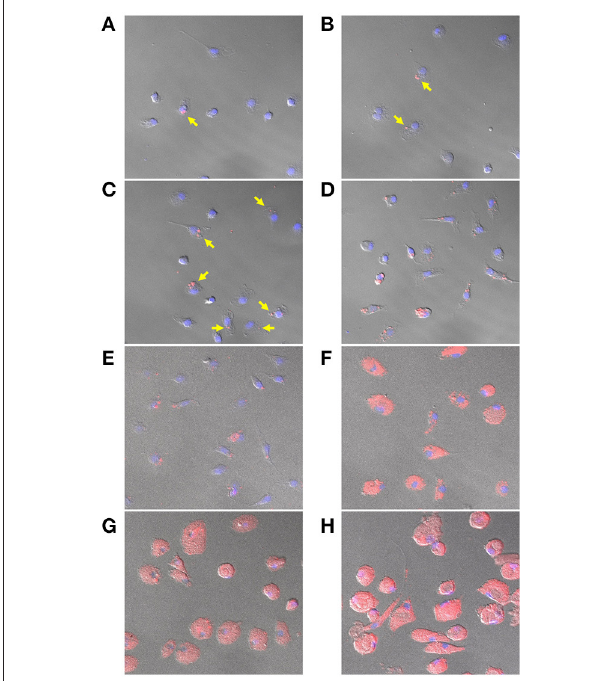
FIGURE 7 | Uptake of NP2-rhodamine by BMDM. BMDM were plated at 10 5 cells per well and incubated with NP2-rhodamine for 30min (A) , 1h (B) , 2h (C) , 4h (D) , 6h (E) , 24h (F) , 48h (G) or 72h (H) . Following incubation, cells were fixed with 4% PFA and slides were mounted with DAPI. Cells were analyzed by confocal fluorescence microscopy (Leica SP8). Blue = DAPI; Red = rhodamine. Arrows indicate internalization of NP2-rhodamine by macrophages at early